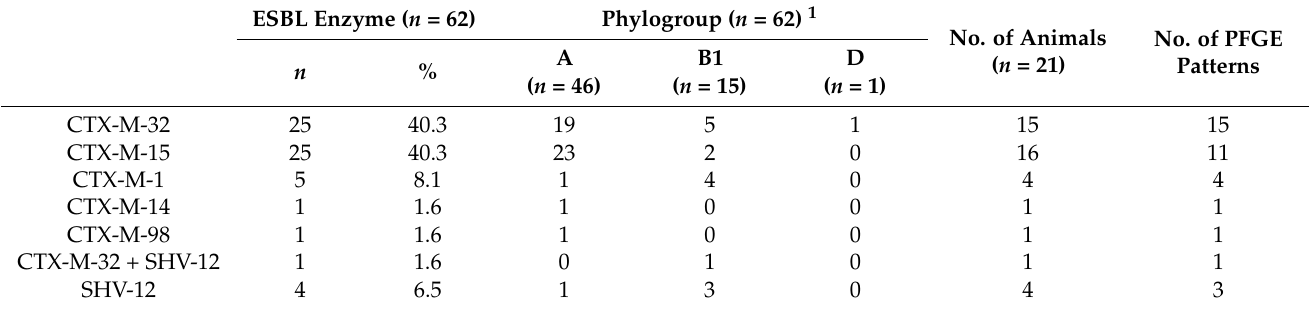
Table 1. Characteristics of all ESBL-producing isolates collected from sheep in Portugal.